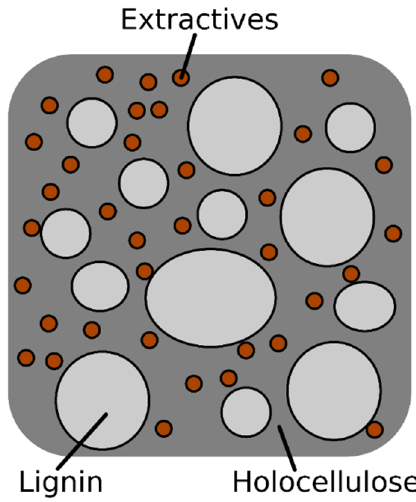
Figure 4. Scheme of chemical surface composition of natural fibers (adapted from Böras and Gatenholm (1999) [41]).